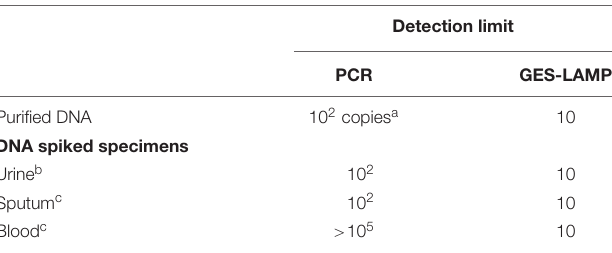
TABLE 4 | Detection limits of the PCR and LAMP assays used to detect DNA from P. aeruginosa of genotype bla GES in DNA-spiked